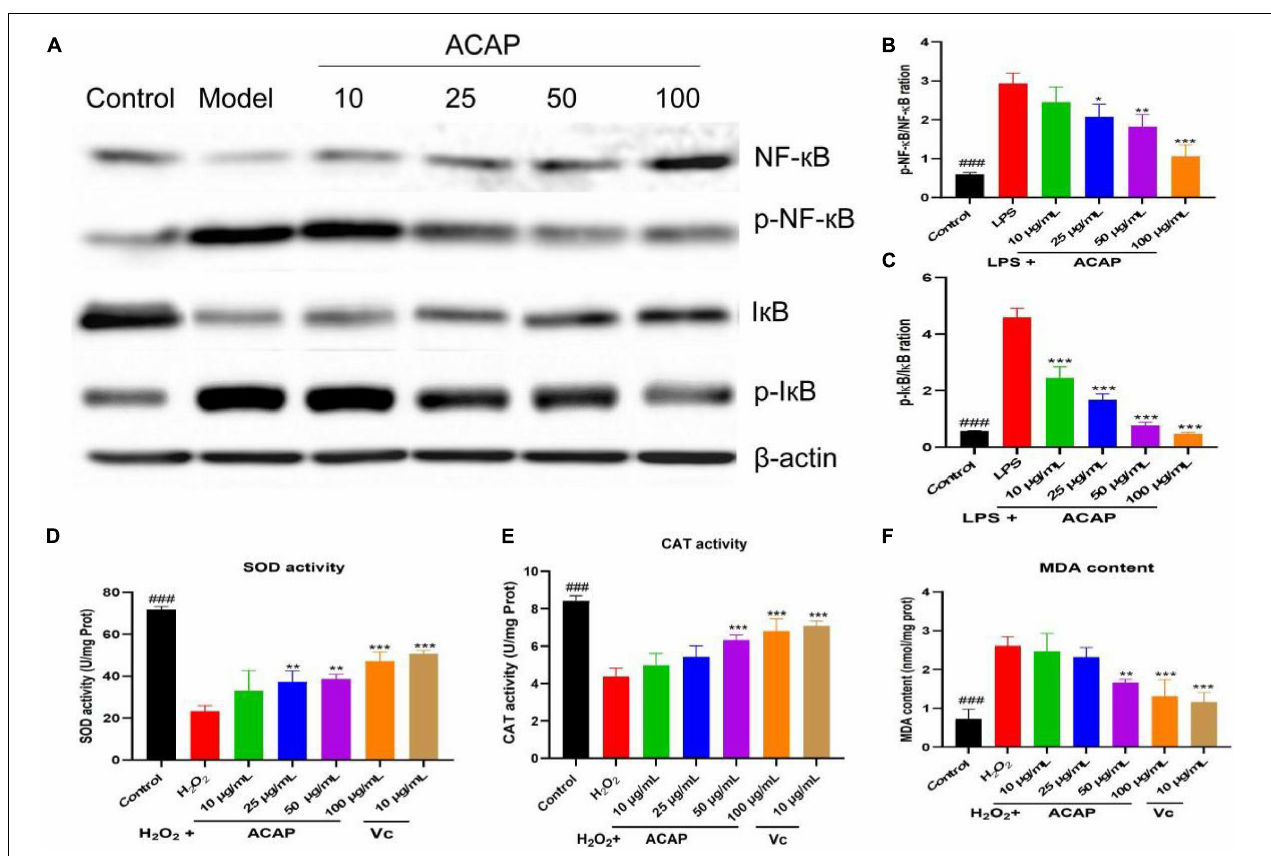
FIGURE 4 | The western blot assay for determining the expression of I κ B, NF- κ B, and Akt (A) , the p-NF- κ B/NF- κ B ration (B) , the p-I κ B/I κ B ration (C) , and the SOD activity (D) , catalase (CAT) activity (E) , and MDA content (F) in RAW264.7 cells induced by LPS ( ### represent the significant difference between control group and model group, p < 0.001; * p < 0.05 represent the significant difference between model group and drug-treated group; ** for p < 0.01; *** for p <